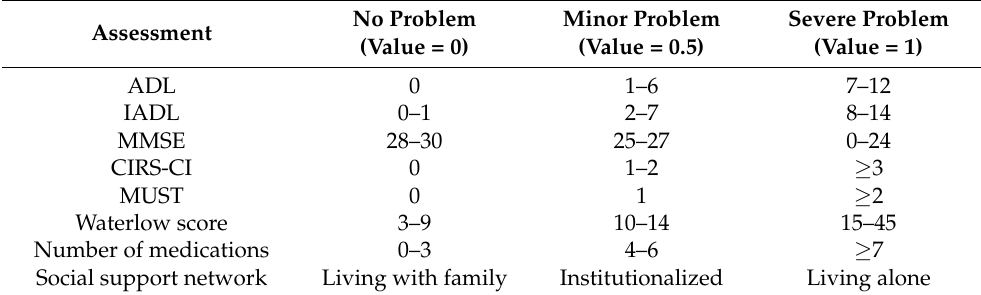
Table 1. Multidimensional prognostic index score assigned to each domain based on severity of the